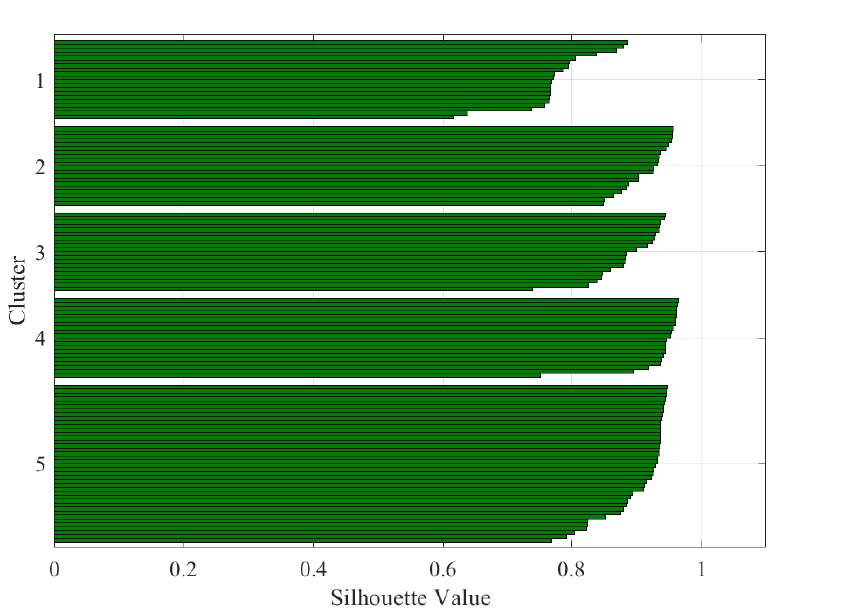
Figure 18. Silhouette plot of combined stator voltage and current, and rotor current harmonics data with k =